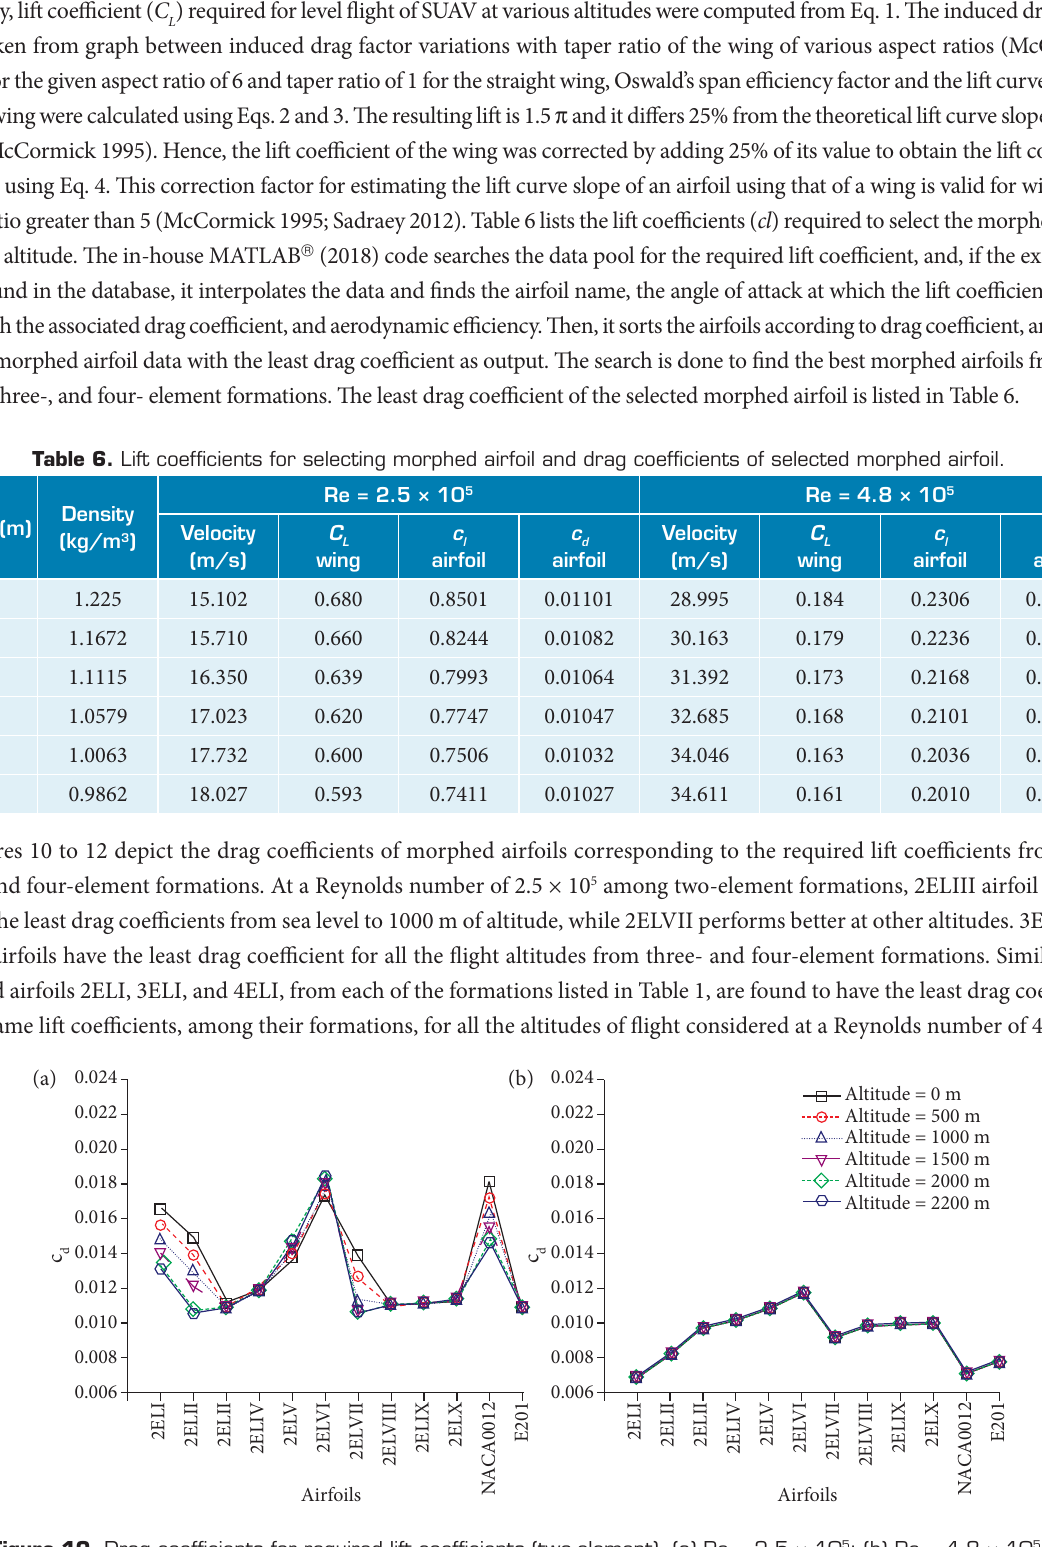
Figure 10. Drag coefficients for required lift coefficients (two-element). (a) Re = 2.5 × 10 5 ; (b) Re = 4.8 × 10 5